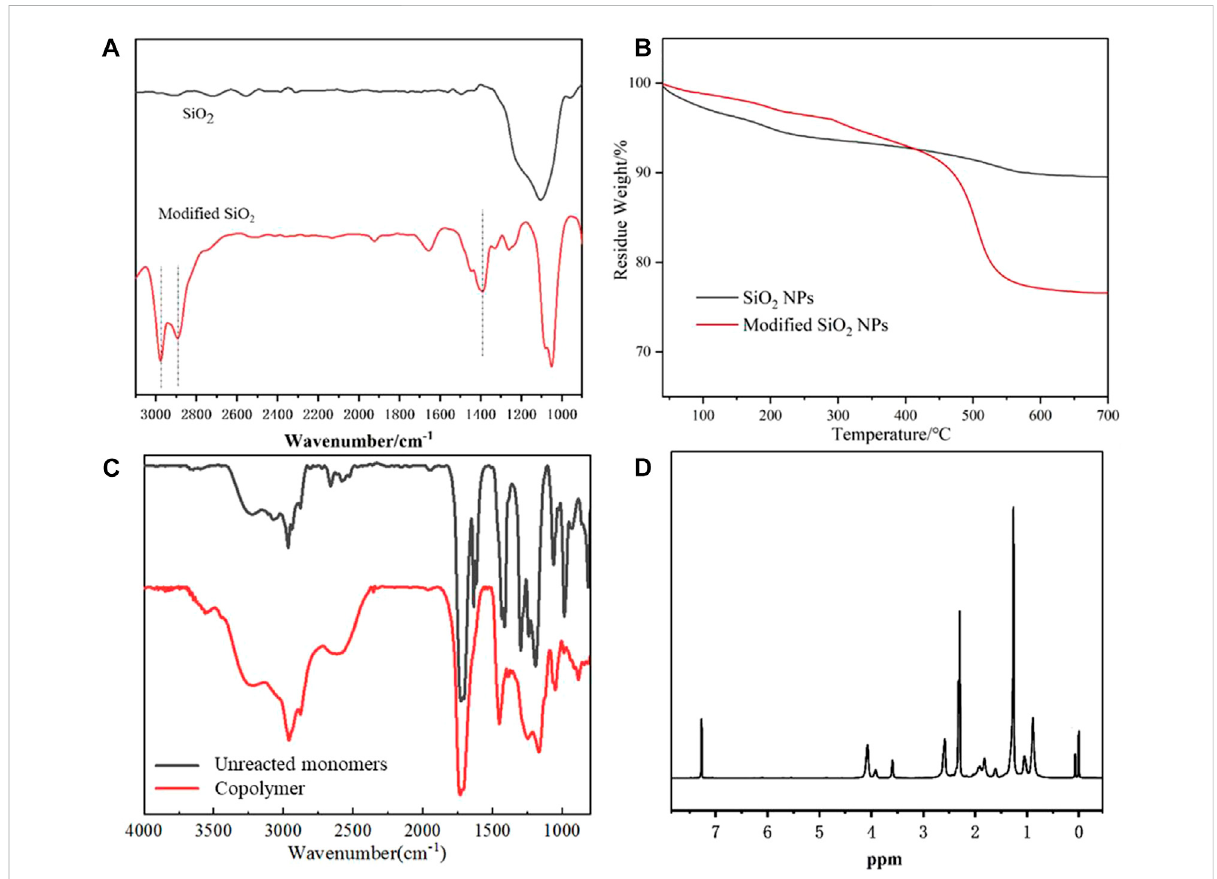
FIGURE 1 FTIR spectra of SiO 2 NPs and modi fi ed SiO 2 NPs (A) , TGA curves of SiO 2 NPs and modi fi ed SiO 2 NPs (B) , FTIR spectra of unreacted monomers and acrylate copolymer (C) , and 1 H NMR of the acrylate copolymer (D)